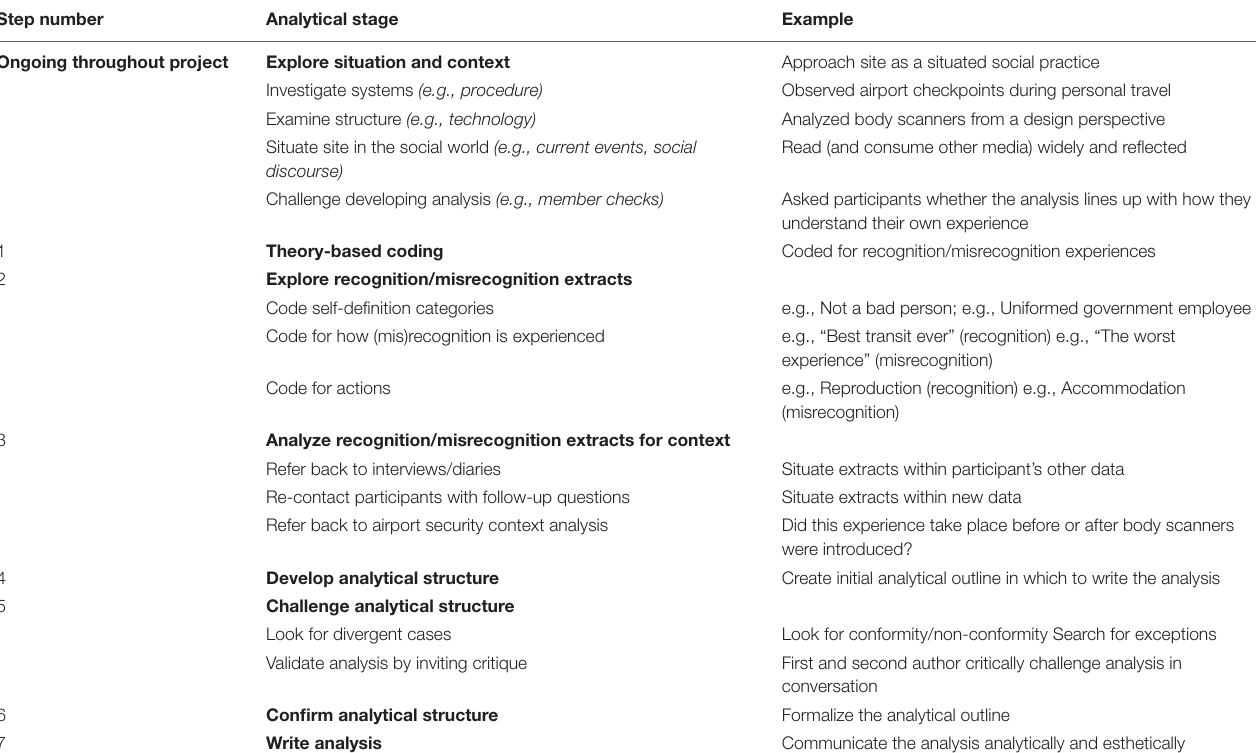
TABLE 2 | Ethnographic practice and analysis